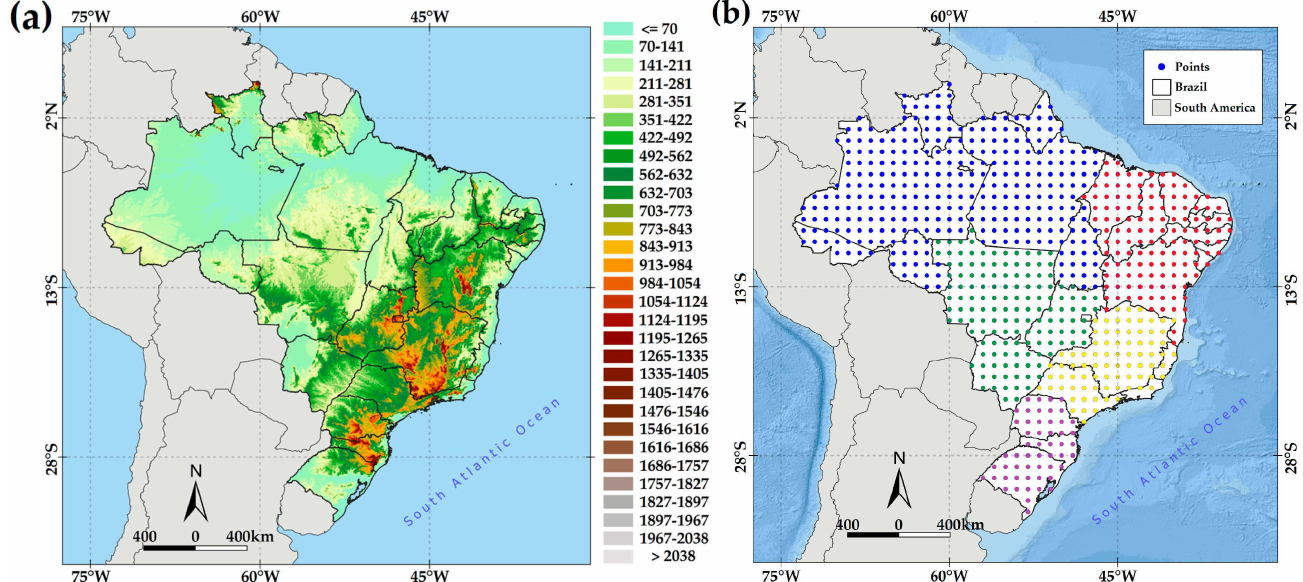
Figure 1. ( a ) Geographical location of Brazil in South America, highlighting its topography, and ( b ) spatial distribution of grid points of data observed and simulated by BAM for intercomparison. In ( b ), the grid points inserted in each region that served as the basis for the sub-regional analyses are highlighted by color: north region (NO), blue; northeast region (NE), red; mid-west region (CO), green; southeast region (SE), yellow; south region (S),